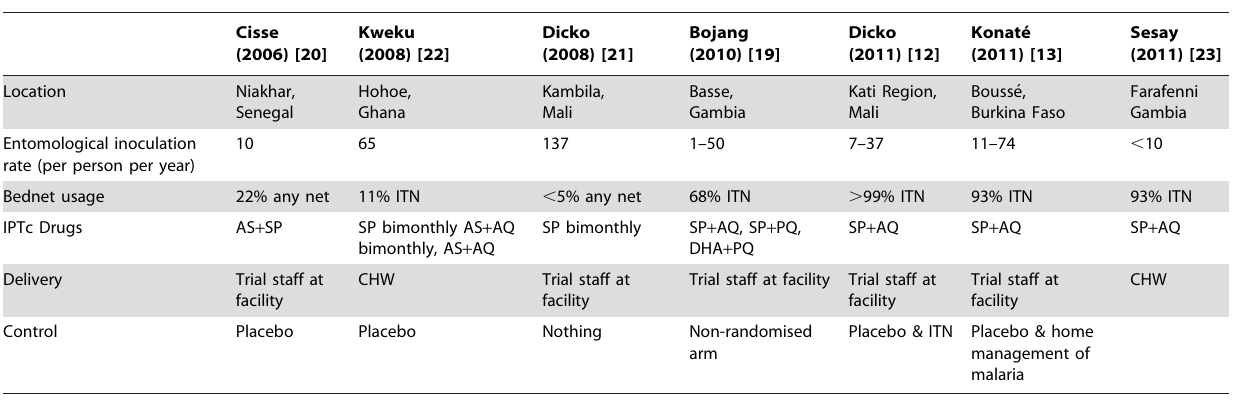
Table 1. Characteristics of Controlled Studies.